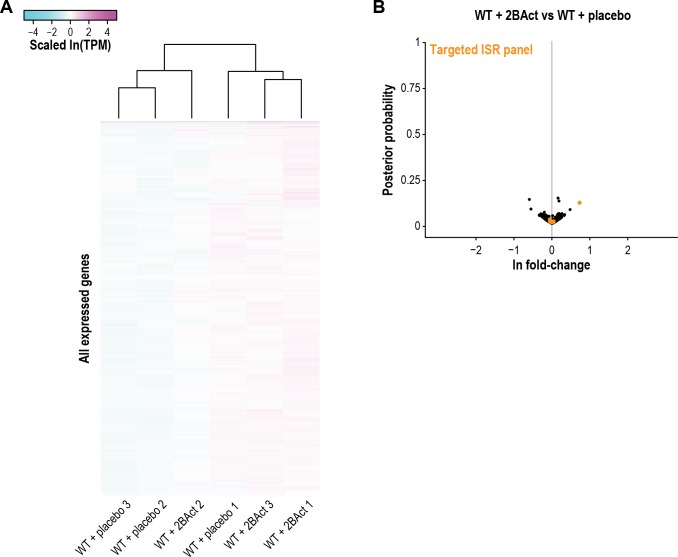
2BAct does not elicit spurious gene changes in WT mice.(A) Heatmap of gene expression changes in WT cerebellum from mice treated with placebo or 2BAct for 4 weeks. The entire analyzed transcriptome is shown. Placebo- and 2BAct-treated samples did not cluster away from each other. Colors indicate the scaled ln(TPM) from the mean abundance of the gene across all samples. Scale limits are the same as shown in Figure 4C and E. (B) Volcano plot showing gene expression changes between 2BAct-treated and placebo-treated WT cerebellum. Orange dots indicate genes from the targeted ISR panel. For (A) and (B), N = 3/condition. Source data are available in Figure 4—source data 2.